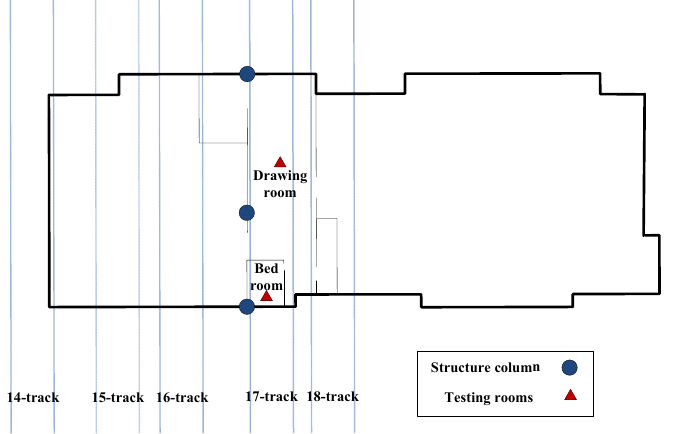
Figure 4. Measuring point location plan.